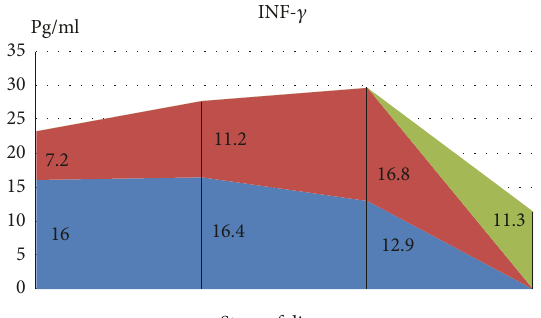
Figure3:Dynamicsofindicatorsofproinflammatorycytokines(IL- 1 𝛽 ) in children with malaria.